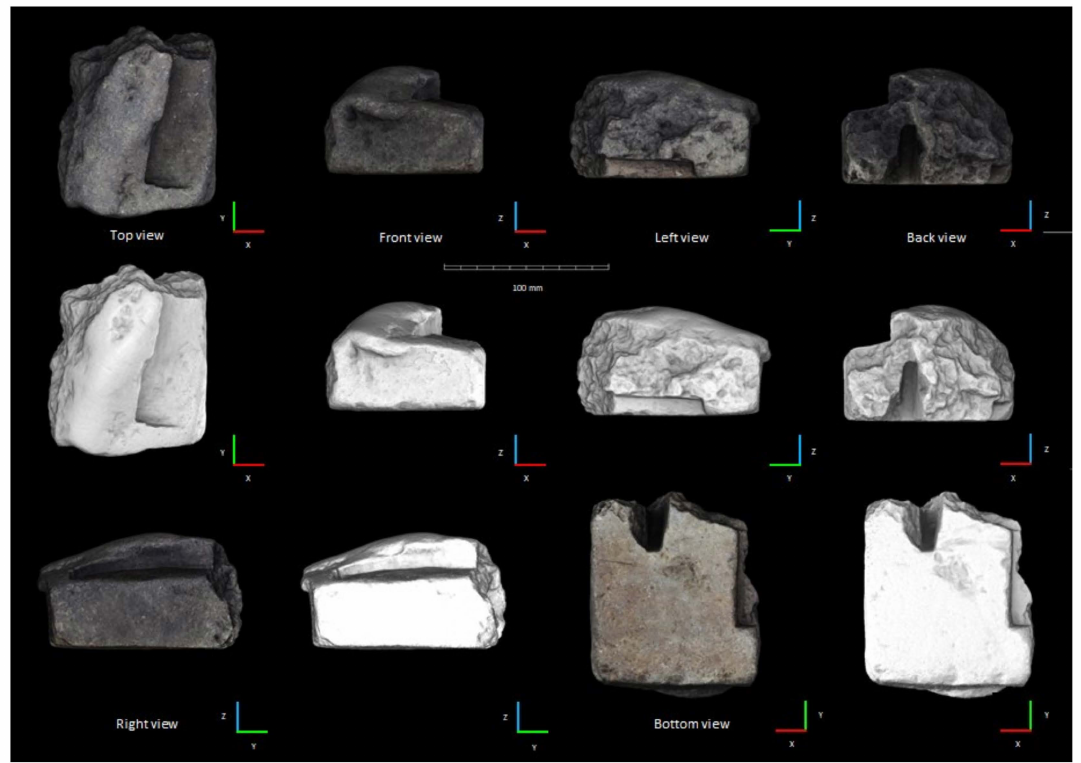
Figure 12. Orthoviews from B2 3D model, with texture and Shade Vis Plug-in; visualization with CloudCompare software.